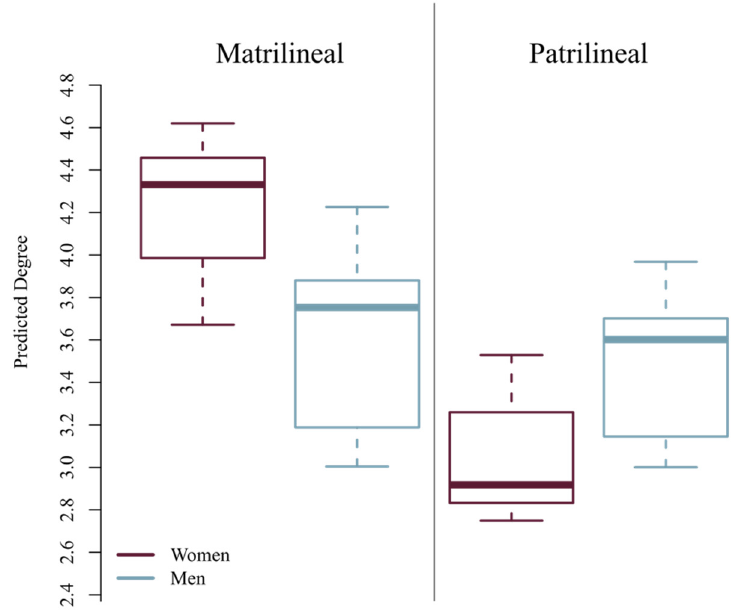
Figure 3. Predicted probabilities for network degree by gender and descent system controlling for survey respondent status and